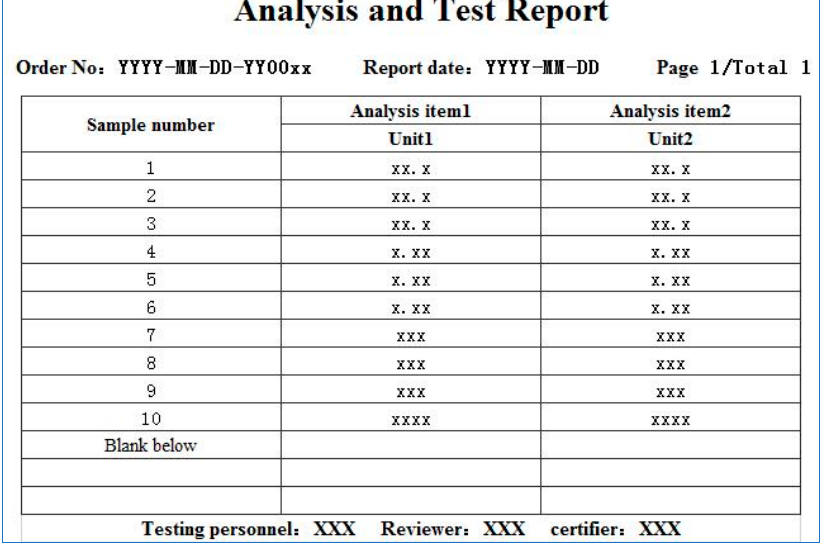
Figure 5. Standard format data report structure. It has clear and specific requirements for row spacing, column spacing, and the number of rows per page. It also has clear requirements for the content, distribution, and size of elements, other than sample data.